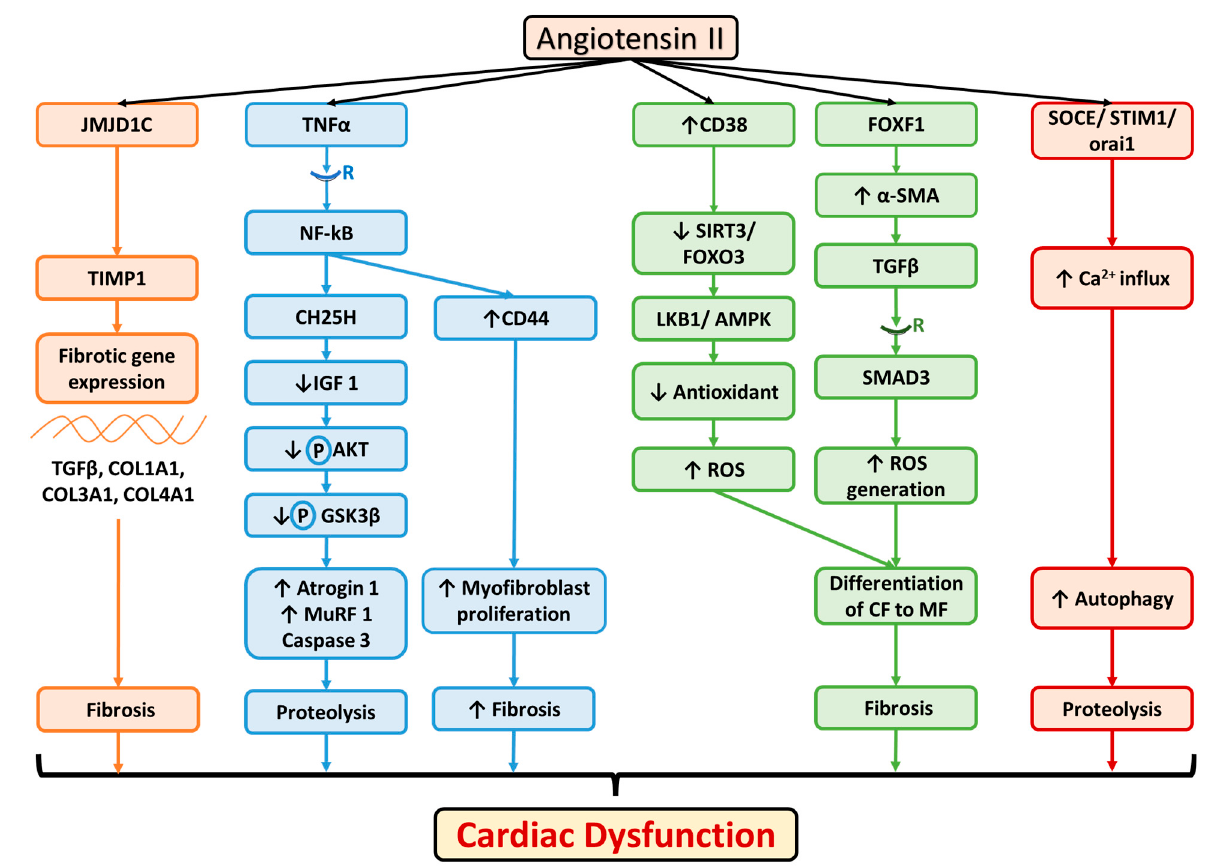
Figure 4. Molecular mechanisms associated with angiotensin II-mediated cardiac dysfunction .